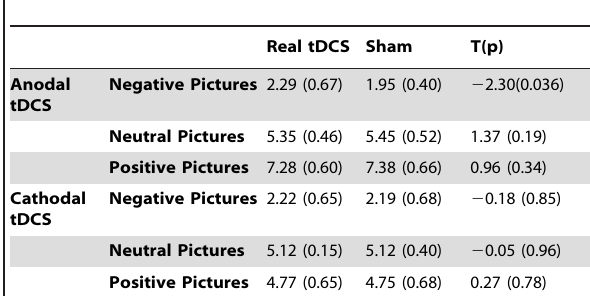
Table 3. Direct (paired t-test) comparisons for each stimulation condition (active and sham) within each emotional valence (negative, neutral and